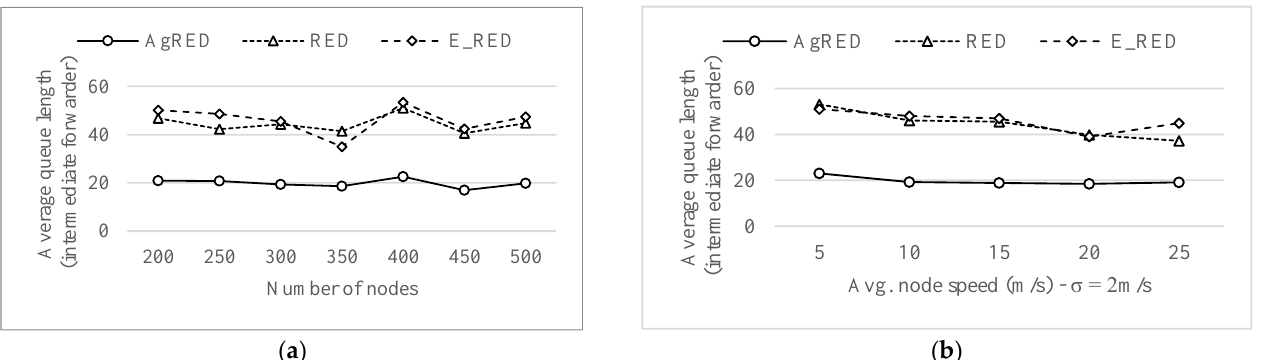
Figure 8. Average queue length of nodes participating in forwarding packets vs. ( a ) number of nodes and ( b ) average node speed.